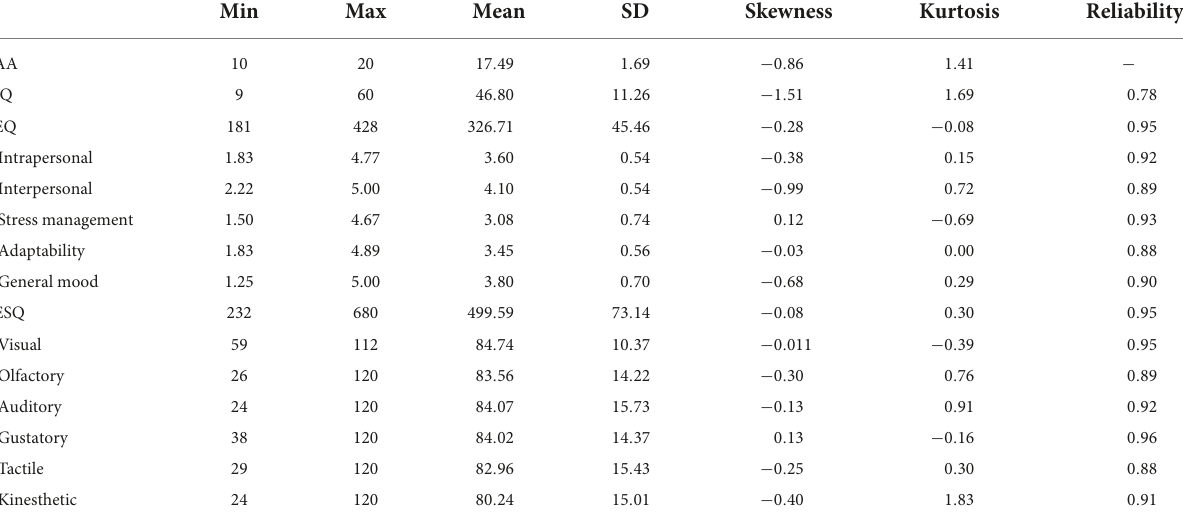
TABLE 1 Descriptive statistics and reliability estimates for AA and the IQ, EQ, and ESQ